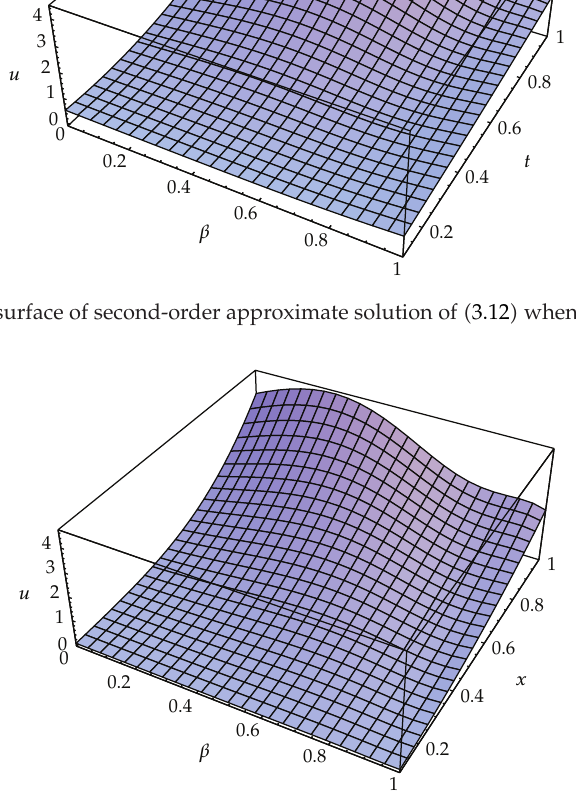
Figure 2: The surface of second-order approximate solution of (cid:2) 3.12 (cid:3) when t (cid:9) 0 . 8, α (cid:9) 1. Table 1: Approximate values and exact solutions when α (cid:9) 1 , β (cid:9) 1 for (cid:2) 3.12 (cid:3)